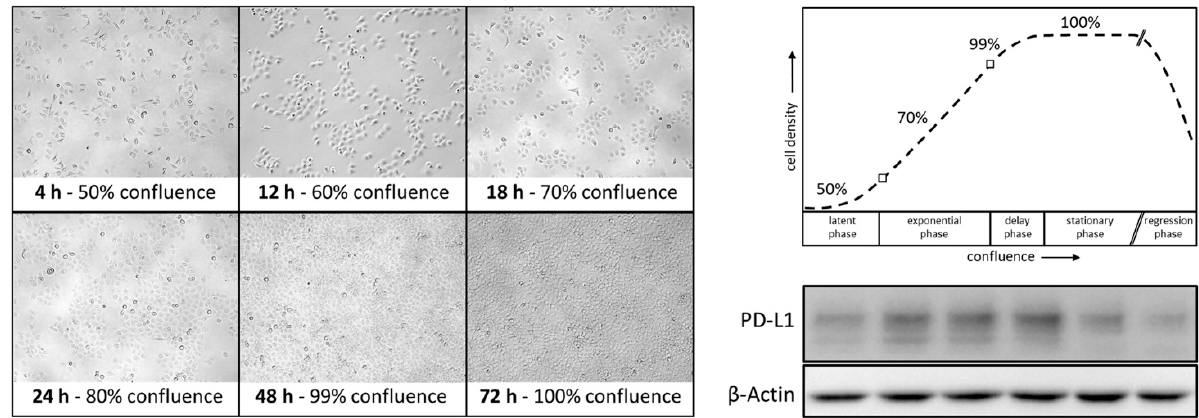
Figure 2. Confluence-dependent expression of PD-L1. HNSCC cell lines were analyzed 4, 12, 18, 24, 48, and 72 h after seeding. Depending on the incubation time and/or cell density, which was recorded by photo documentation at 20-fold magnification, different PD-L1 expression levels could be detected. Here, cell line PCI 9 is shown as a representative example of the WB analysis. β -actin served as a loading control.